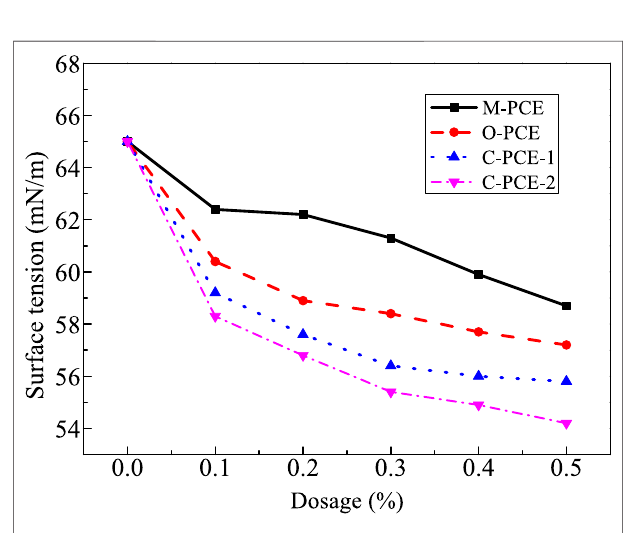
FIGURE 15 | Liquid surface tensions of polycarboxylate in cement pastes at varied dosages.